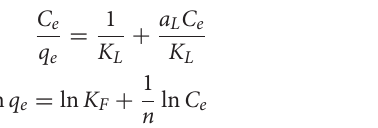
FIGURE 7 | Van’t Hoff plots of iodine adsorption over JLUE-COP-3.